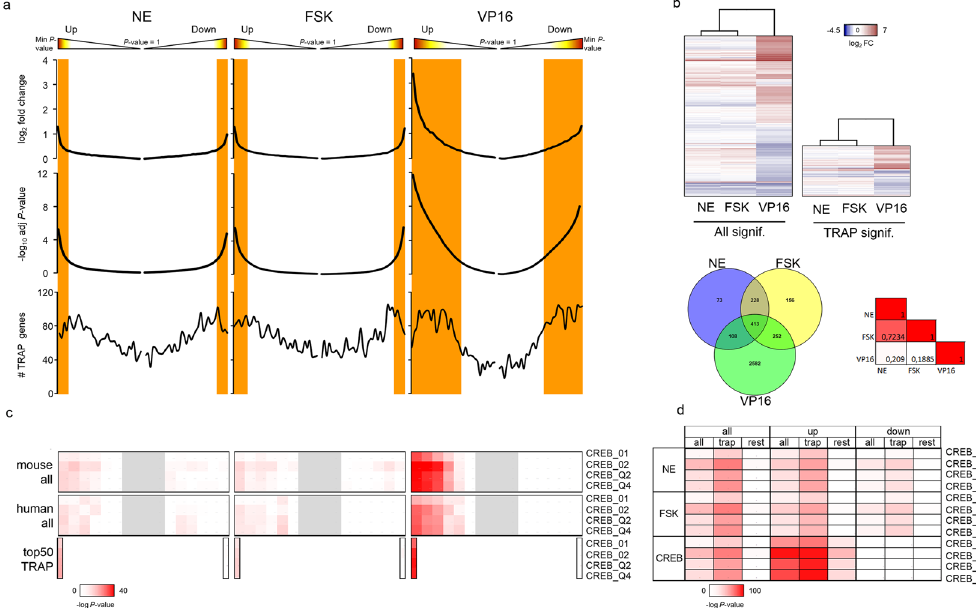
Figure 2. Transcriptome profiles. ( a ) Gene distribution according to fold change, adjusted p-values, and direction of change (UP or DOWN). Orange shades are regions of significance (adjusted p -value < 0.05). TRAP genes are genes in the first quartile (Q1) of the TRAP list. Bins of 250 genes were used to calculate the median of fold change and p -value, and to count the number of TRAP genes in each bin. ( b ) Heatmaps, Venn diagrams and Pearson correlations of differentially expressed genes. Top, gene clustering according to log 2 FC by Euclidean distance in the initial transcriptome (ALL genes) and in the list of genes filtered by Q1-TRAP list of adult astrocyte genes. Bottom, Venn diagrams of differentially expressed genes and Pearson correlations. There are major transcriptome changes upon VP16-CREB over-expression as compared to stimulation with FSK or NE, and the latter groups are highly similar. The same patterns are observed in ALL and TRAP genes. ( c ) PSCAN analysis of CRE-enrichment probability in ‘all’ and Q1-TRAP-filtered genes using promoters of mouse and human orthologs. The probability of CRE occurrence is highlighted in a spectrum of reds. Gray shades are transcriptome regions not analyzed. Rows are different matrices containing variations of CRE motifs. CRE- containing genes are enriched in the UP portion in all lists. ( d ) PSCAN analysis comparing ‘all’, ‘Q1-TRAP’ and ‘rest’, or remaining genes. CRE-containing genes are enriched in Q1-TRAP genes as compared to ‘rest’